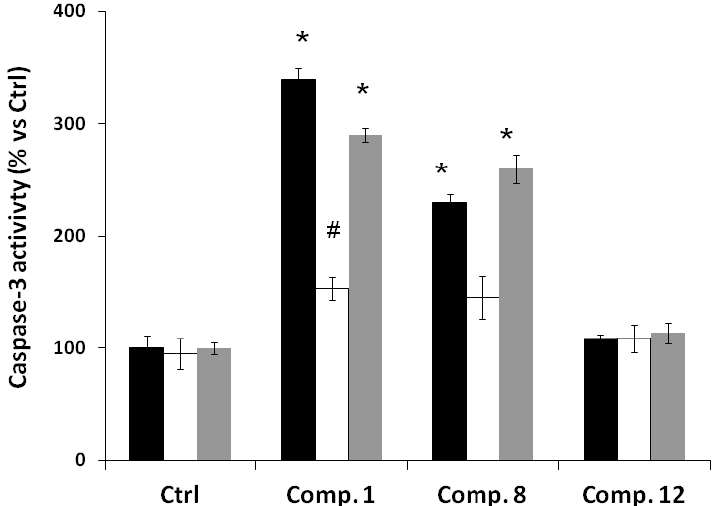
Figure 5. Effect of compounds 1 , 8 , and 12 on caspase-3 activity of MCF-7 (black), CoN (white) and PC-3 (grey) cells. Cells were exposed to compounds at 50 μ M for different times. Values are mean ± S.D. ( n = 3). All data are reported as the percentage change in comparison with the vehicle-treated cells (1% ethanol), which were arbitrarily assigned 100%. # p < 0.05, significantly different from the vehicle-treated cells (1% ethanol in medium, that is, compound concentration = 0) and * p < 0.001, significantly different from the vehicle-treated